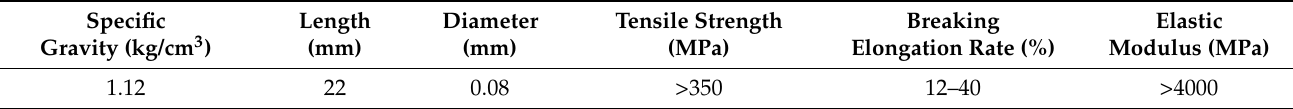
Table 4. The physical and mechanical characteristic of PPF.